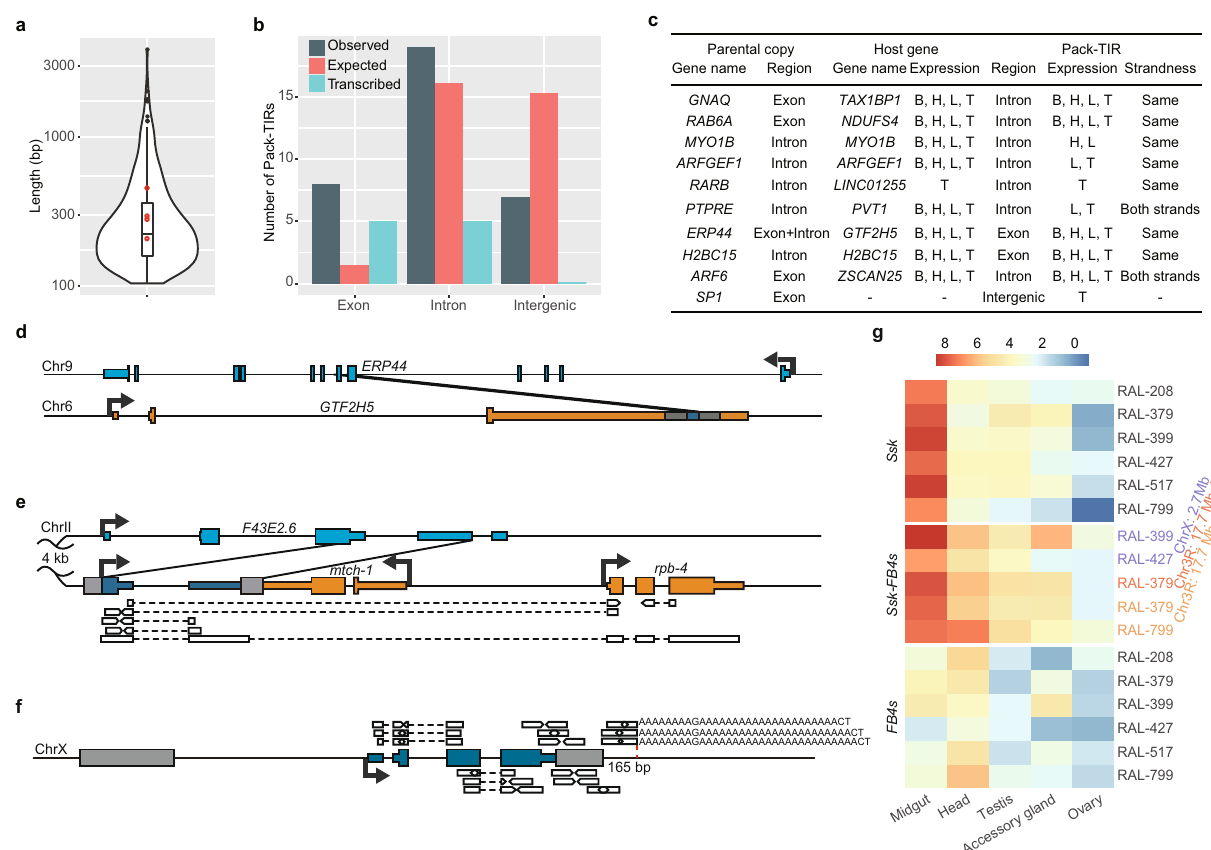
Fig. 4 Sequence and transcriptional features of Pack-TIRs. a Length distribution of the internal sequences ( n = 281 samples). The distribution is shown as a violin plot in Fig. 2f. The four red dots represent the multicopy Pack-TIRs. b Distribution of parental sequence types in humans. “ Observed ” shows the actual numbers of Pack-TIRs divided by the functional types of their parental sequences; “ Expected ” shows the numbers calculated based on the proportion of all annotated exons and introns; and “ Transcribed ” shows the numbers of transcribed Pack-TIRs in each category. c Transcribed human Pack-TIRs. Host genes indicate the genes into which Pack-TIRs were inserted. “ B ” , “ H ” , “ L ” , and “ T ” indicate the brain, heart, liver, and testis, respectively. d One human example showing 3 ′ UTR chimerism. The fi gure convention follows that of Fig. 1d with the exception that the host gene is marked in orange and the transcription direction is shown by thick arrows. e One worm example showing 5 ′ UTR chimerism. The parental gene is close to the host gene at a 4-kb distance. The boxes connected by dashed lines indicate the spliced RNA-sequencing (RNA-seq) reads. Blank arrows indicate paired-end Illumina short reads. The bottom long read was generated on the Nanopore platform ( “ Methods ” ). Note: mtch-1 and rpb-4 are divergently transcribed. f Gene structure of Ssk-FB4 in D. melanogaster at chrX: 2.7 Mb. Ssk-FB4 is highly transcribed in the midgut, and only a few representative spliced reads spanning breakpoints between the internal sequence and TE and reads supporting continuous transcription toward 165-bp (marked by a red dashed line) downstream regions are shown. Note: the reads containing poly(A) tails have non-A residues, consistent with a previous report 46 . g Heatmap showing the expression pro fi le of Ssk , Ssk-FB4s, and FB4s in fi ve tissues in D. melanogaster . The expression levels were quanti fi ed as log 2 transformed TPM (transcripts per million mapped reads, n = 2 biologically independent